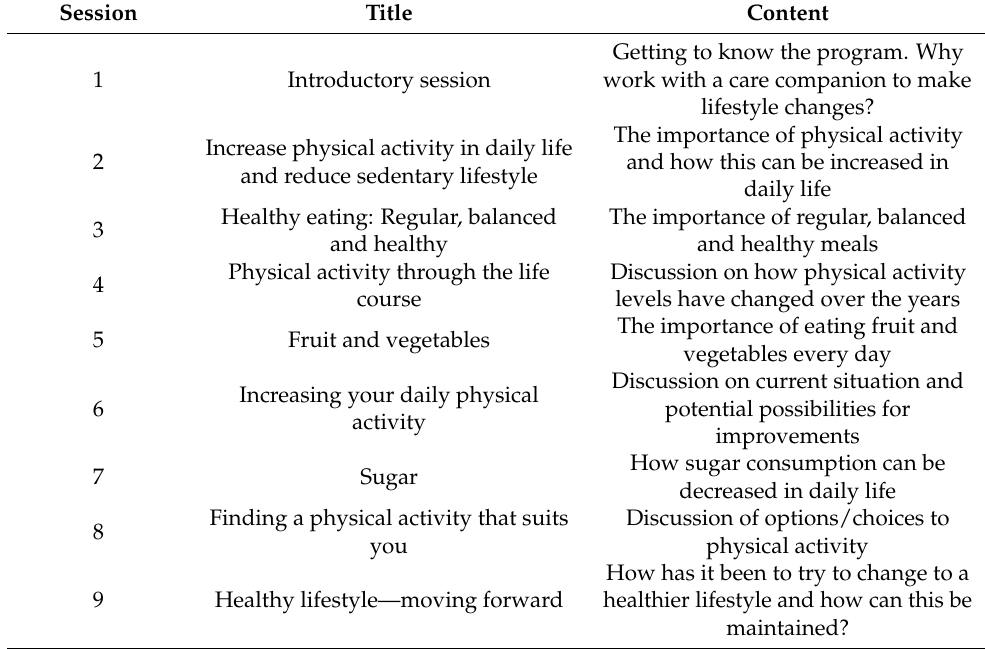
Table 1. Telephone-facilitated health coaching sessions included in the Swedish SMART2D intervention.